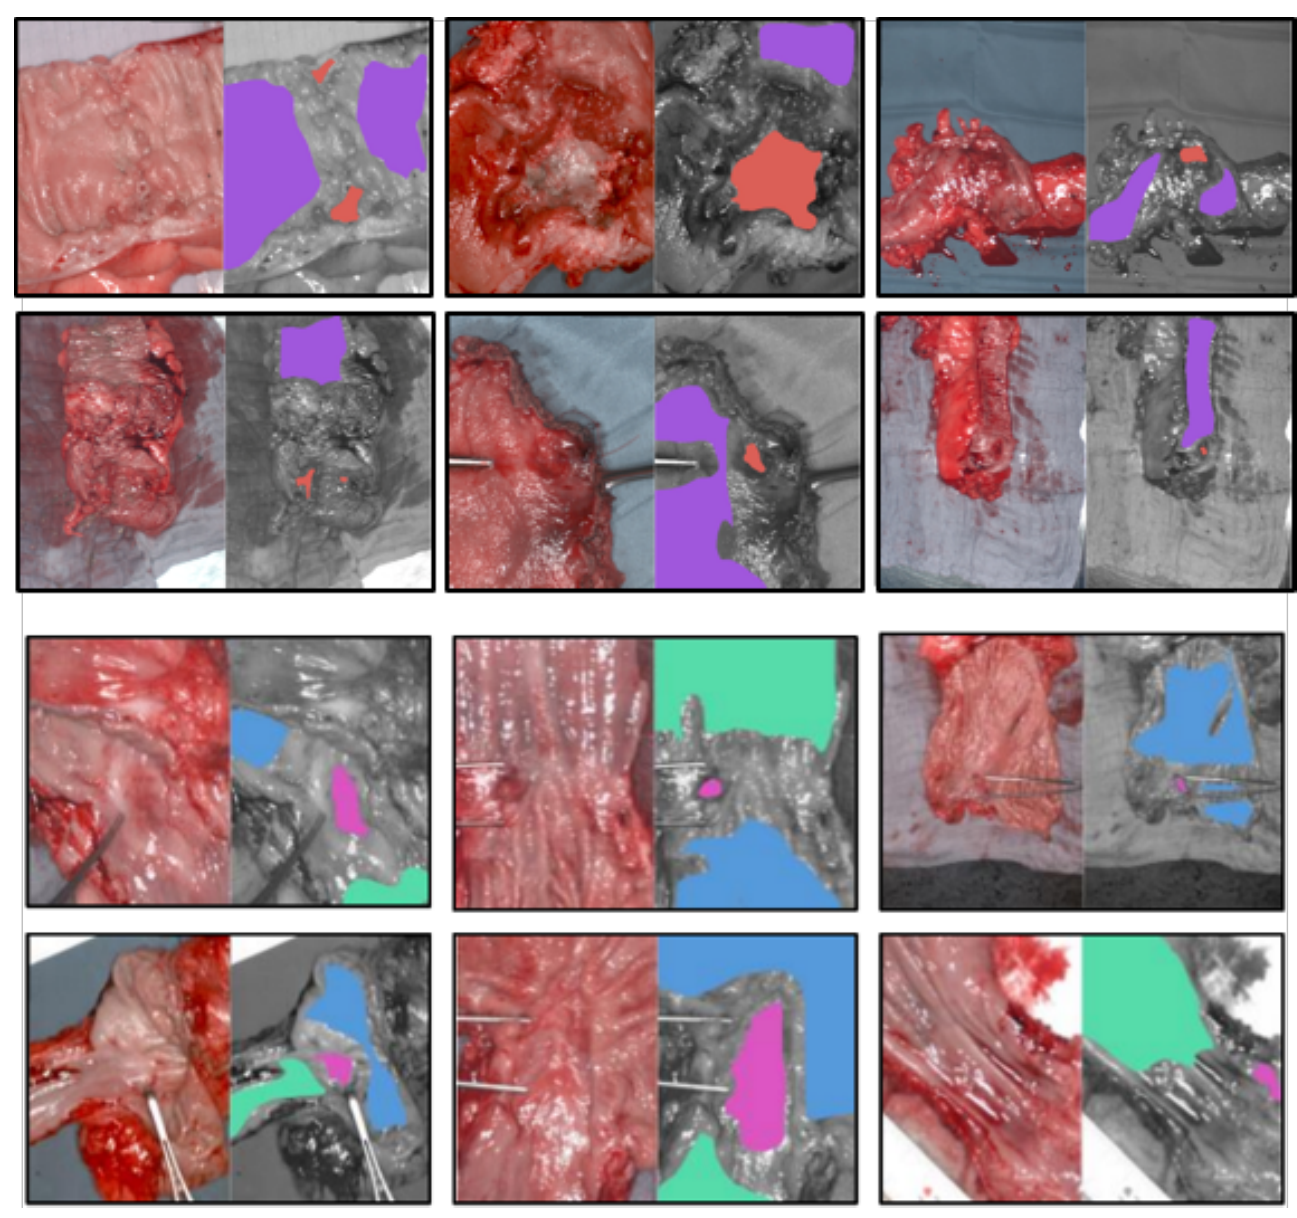
Figure 1. Example annotated images from the colon and esophagogastric datasets. The top two row shows RGB images of colon samples with associated annotations side-by-side: purple annotation is for healthy colon tissue, red is for cancer tissue. The bottom row shows stomach and esophagus samples: green annotation is for healthy esophagus tissue, blue for healthy stomach tissue and pink is for cancer